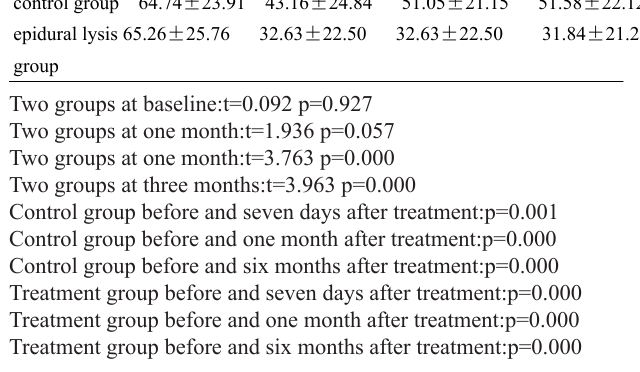
TABLE 2 - VAS scores before operation, seven days, one month, six months post operation.